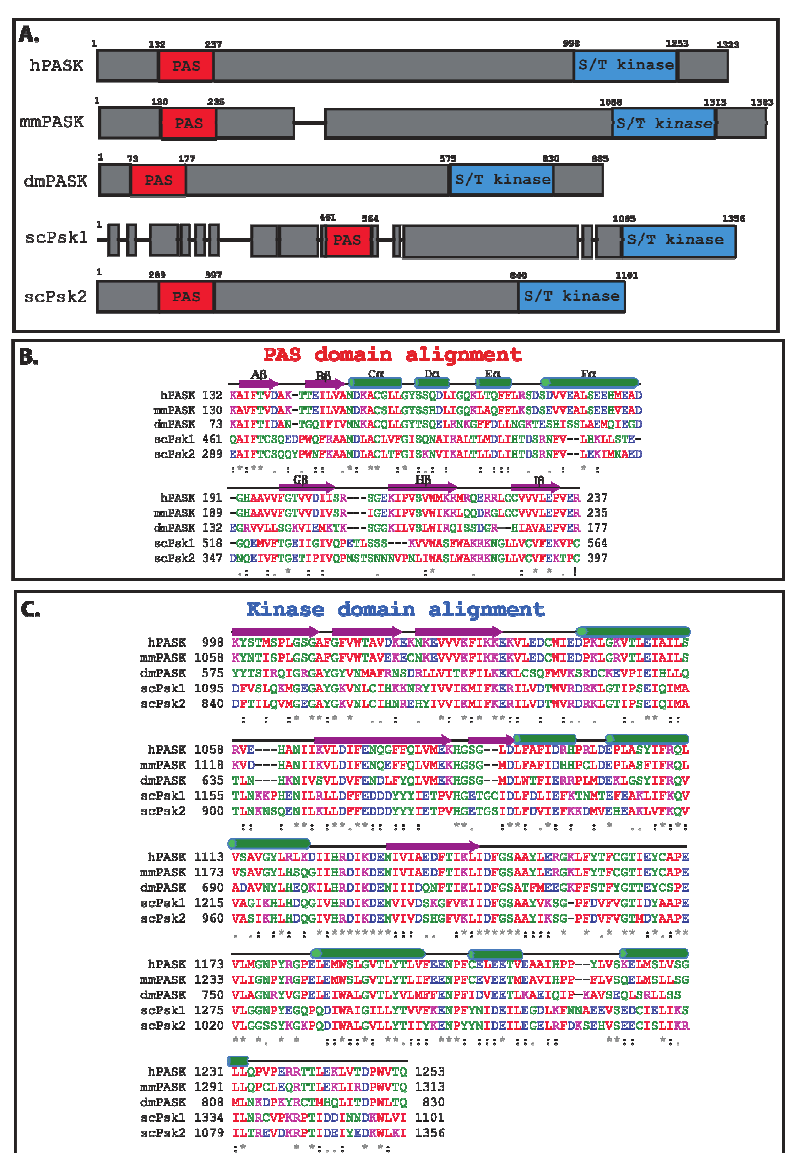
Figure 2. Alignment of the PAS and kinase domains from selected PAS kinase orthologs. (A) Schematic of PAS kinase homologs. Regions of similarity are boxed in grey, with non-homologous regions indicated by gaps between the grey boxes. Alignment of the PAS (B) and kinase (C) domains from selected PAS kinase orthologs. Secondary structure elements ( α -helical and β -sheet) were derived from the published NMR structure of the PAS domain [27] as well as amino acid alignment of the kinase domain with the published structure of microtubule-associate protein/microtubule affinity regulating kinase 2 (MARK2) [33], and are shown above the amino acids in green and purple respectively. Amino acid sequences were aligned using the Clustal W program [34]. The degree of amino acid conservation is indicated both by color and “*” (identical residues in all sequences), “:” (highly conserved amino acids), and “.” (weakly conserved amino acids). Red indicates a small hydrophobic or aromatic amino acid (-Y), blue indicates acidic, magenta is basic, and green is hydroxyl plus amine plus basic (-Q), all other amino acids are